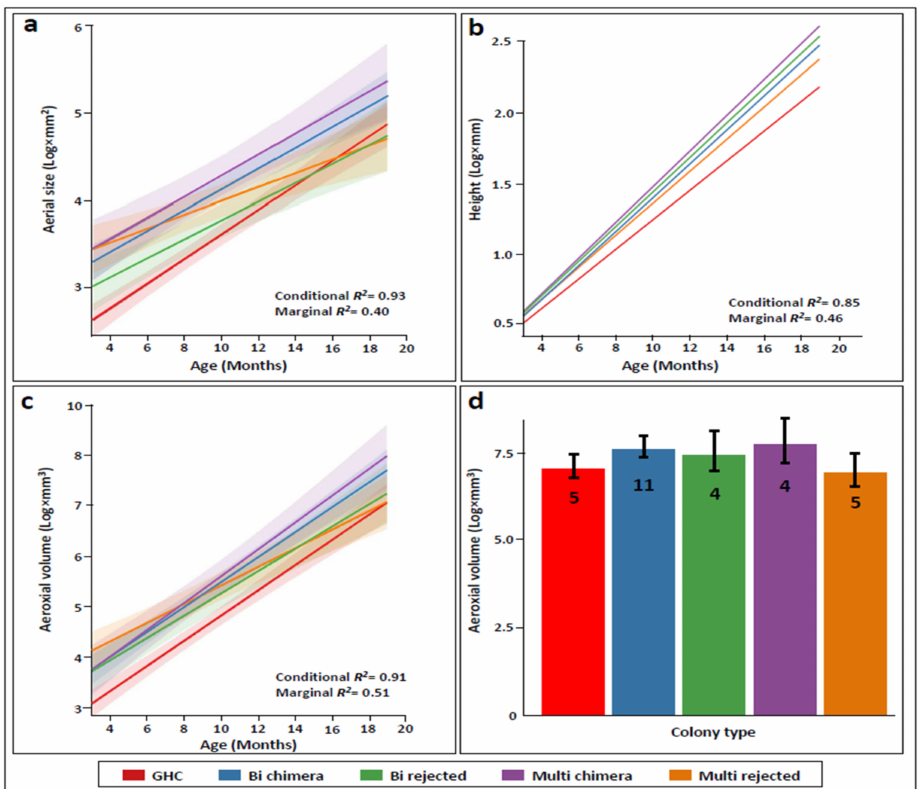
Figure 2. The best fitted mix linear models for ( a ) areal size (mm 2 ), ( b ) height, and ( c ) aeroxial volume. Covariate ( X -axis) is age in months, random factors are the samples. Each line represents a linear model for each colony type as described in the caption. Conditional R 2 (the proportion of variance explained by the whole model) and marginal R 2 (proportion of variance explained by the fixed factor alone) are attached to each sub-figure. ( d ) Mean log aeroxial volumes with SE in colonies sampled at the age of 18 months (real values, not from the model). Number above bars depicts the number of